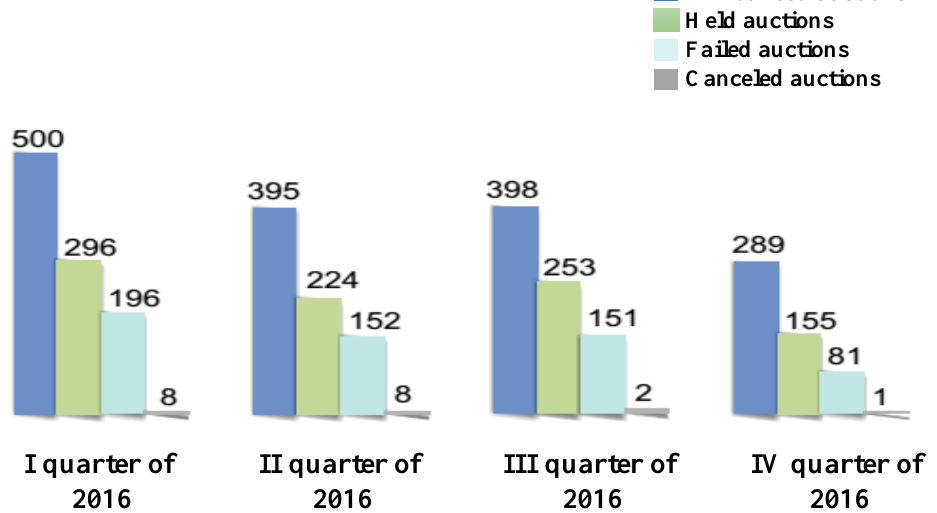
Fig. 2. Table on the auctions announced in 2016 (National Agency of State Property, n.